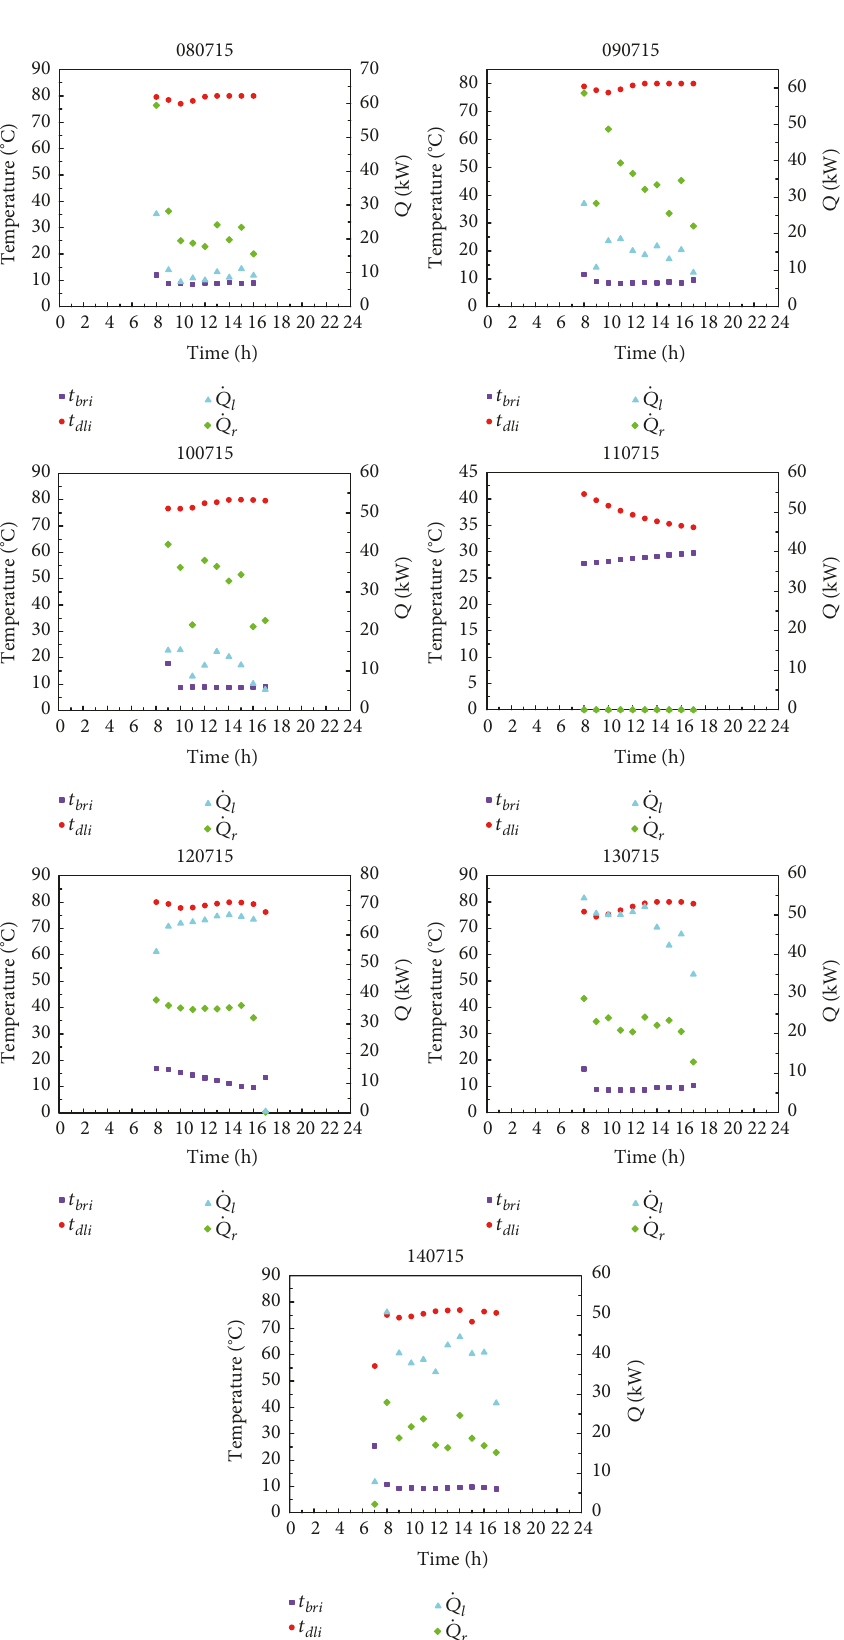
Figure 6: Instantaneous characteristics of SHC from 08 July 2015 to 14 July